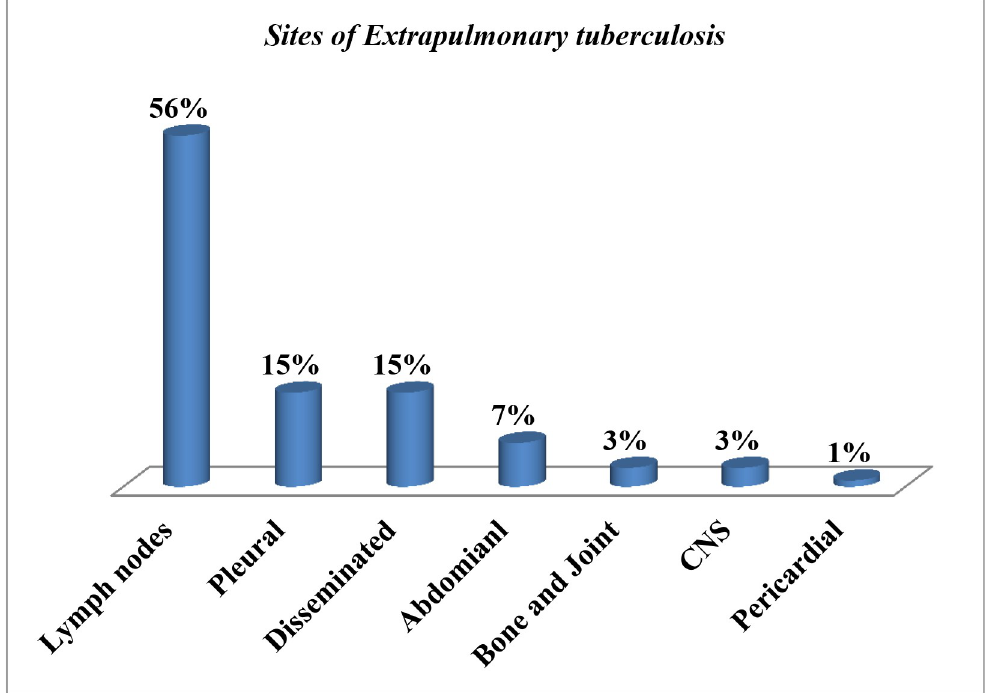
Fig 2. Sites of extrapulmonary TB among HIV positive patients in Addis Ababa, Ethiopia, from 01 January 2013 up to 31 December 2018 (n = 72).